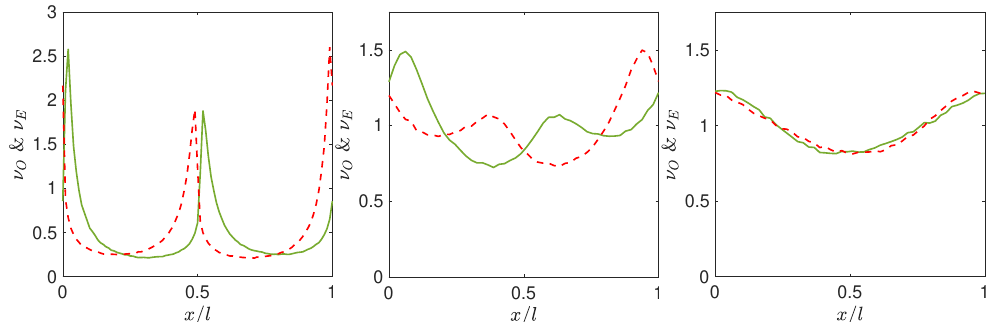
Figure 9: Distribution of the (chiral) operator evolution ν (green solid lines) within O one wavelength of deformation. The protocol and driving parameters are the same as = 0.0005, 0.01, and 0.1 those in Fig. 7 and Fig. 8. From left to right, we take ∆ T / l eff respectively. The red dashed lines are the distribution of (chiral) energy-momentum = 10 6 in the ensemble density peaks ν . We take N E sample